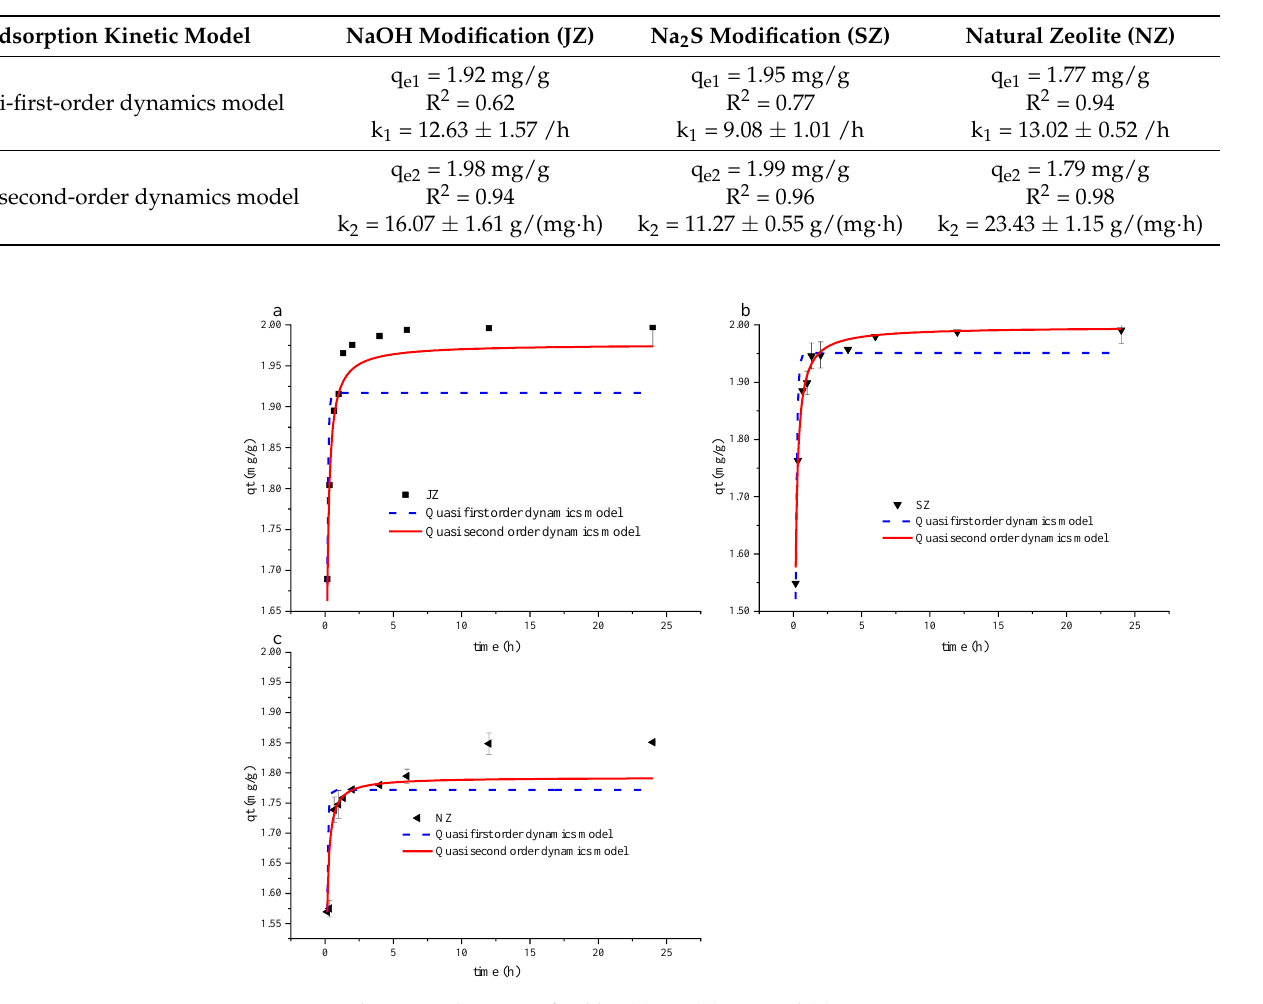
Figure 6. Adsorption kinetics of Cd by ( a) JZ, ( b) SZ, and ( c ) NZ.